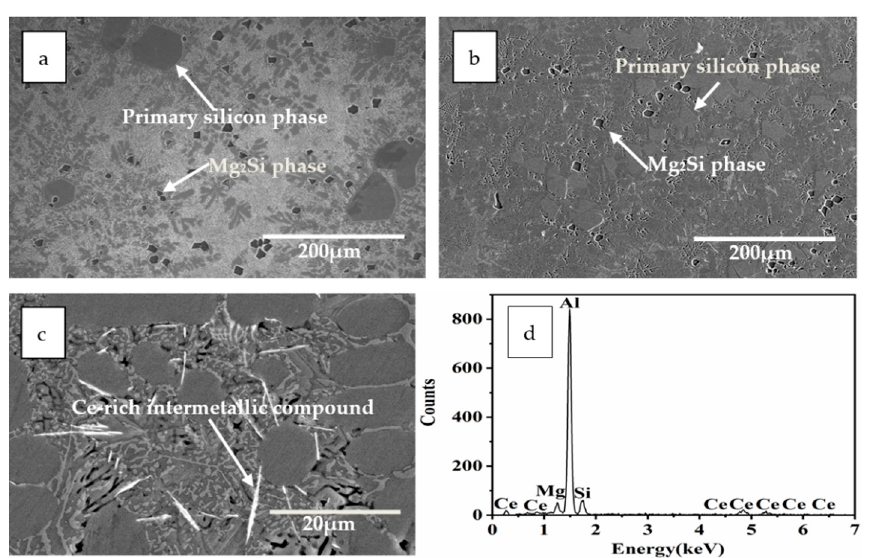
Figure 1. SEM morphology micrographs of Al–20Si–5Mg and Al–20Si–5Mg–0.7Ce alloy surfaces without HCPEB irradiation. ( a ) SE image, Al–20Si–5Mg; ( b ) BSE image, Al–20Si–5Mg–0.7Ce; ( c ) magnified micrograph of Figure 1b; ( d ) EDS results of Ce-rich intermetallic compound in Figure